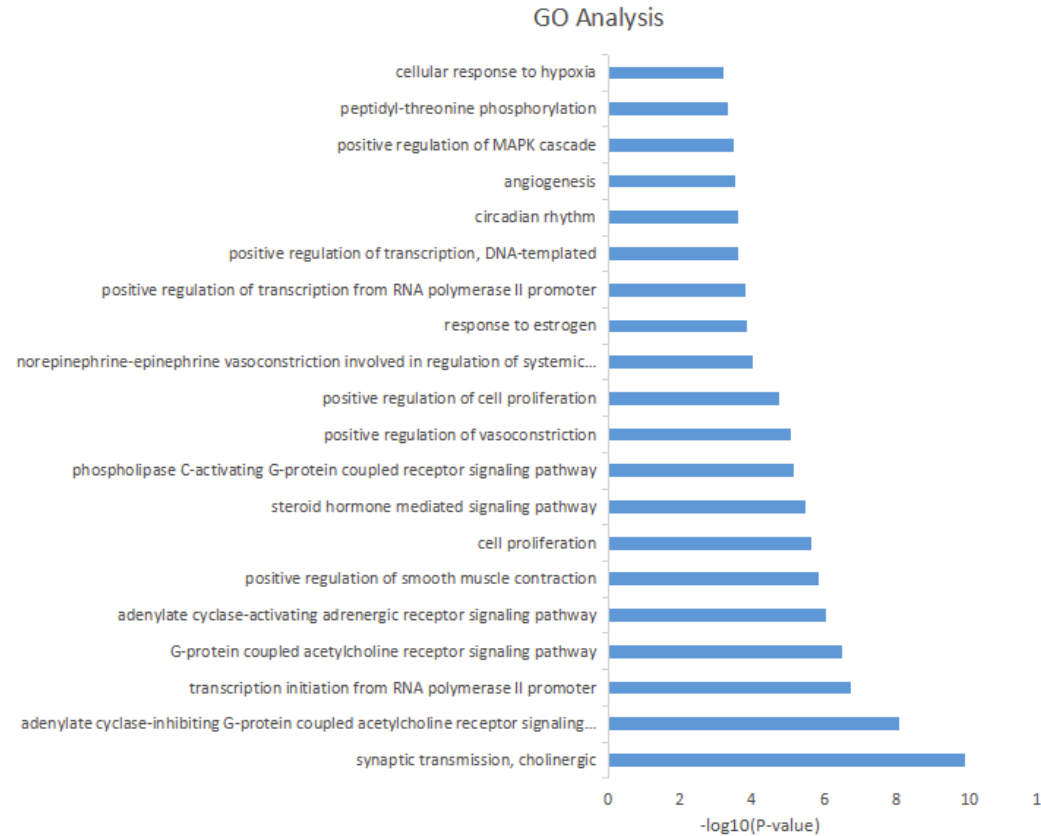
Figure 3 - Gene Ontology (GO)analysis of therapy target genes. They-axis shows signifi cantly enriched ‘Biological Process’ categories in GO of the target genes, and thex-axis shows the enrichment scores of the seterms(P-